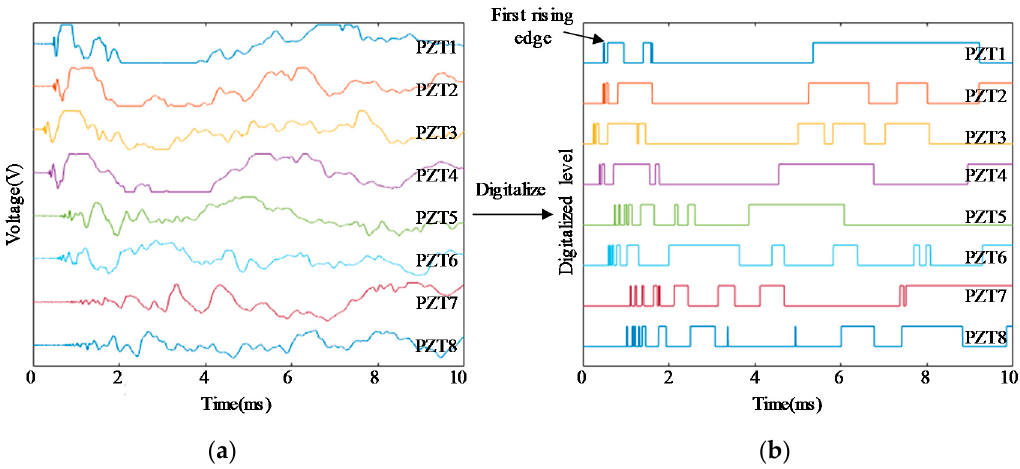
Figure 3. An example of impact response signals and the corresponding CDSs: ( a ) Impact response signals and ( b ) CDSs.